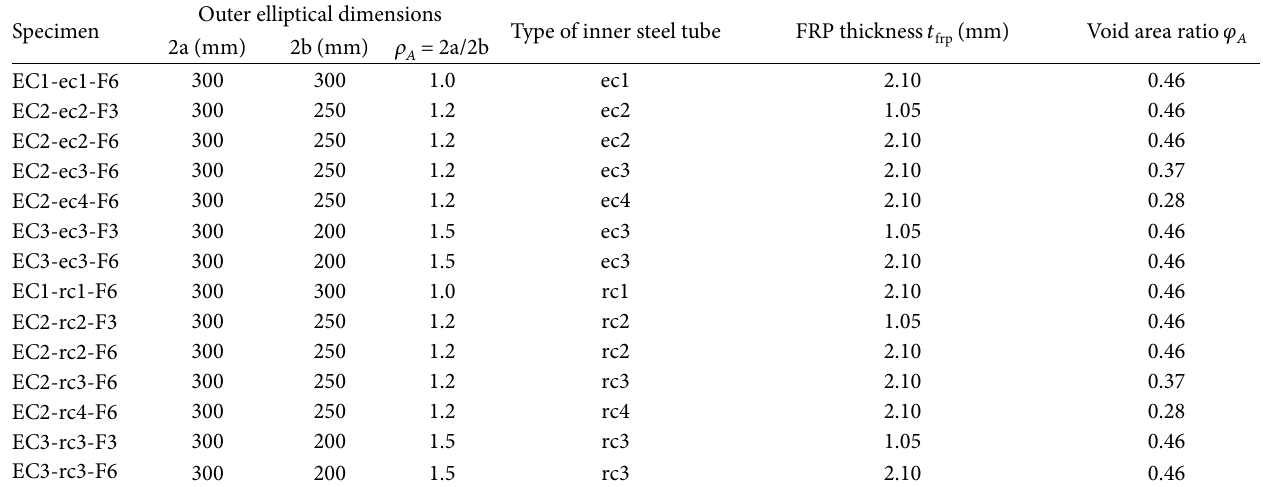
Figure 3: Elliptical DSTCs with a rectangular steel tube. (a) EC1-rc1-F6. (b) EC2-rc2-F3 and EC2-rc2-F6. (c) EC2-rc3-F6. (d) EC2-rc4-F6. (e) EC3-rc3-F3 and EC3-rc3-F6. Table 1: Specimen details.